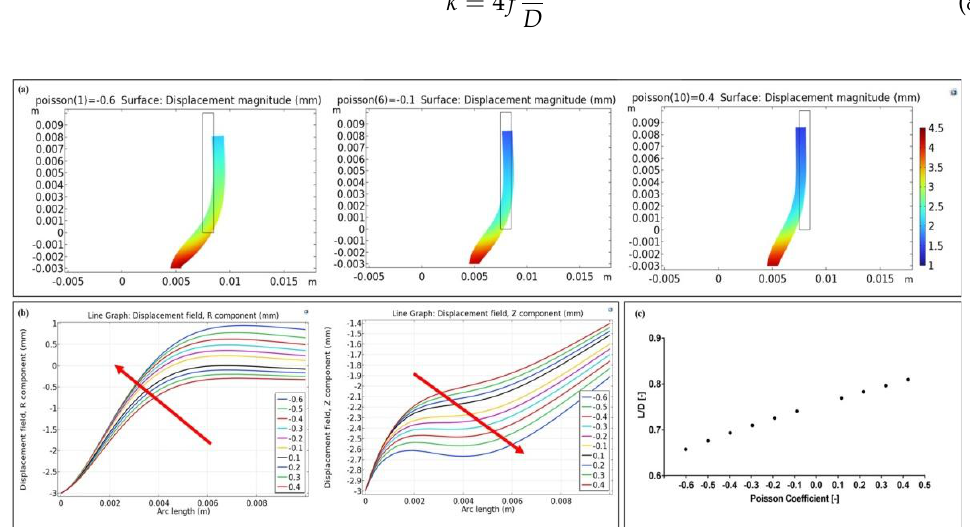
Figure 6. Results of the FE models. ( a ) The frame shows the magnitude of the silicone tube when three different Poisson coefficients were simulated (i.e., − 0.6, − 0.1, 0.4). ( b ) Displacement along r and z of the inner wall of the silicone tube (blue line, Figure 1c) as the Poisson coefficient varied. The red arrows indicate the increase of the auxetic feature. ( c ) The L/D ratio as the Poison coefficient varied, showing that the auxetic behavior decreased the pressure loss in the tube.